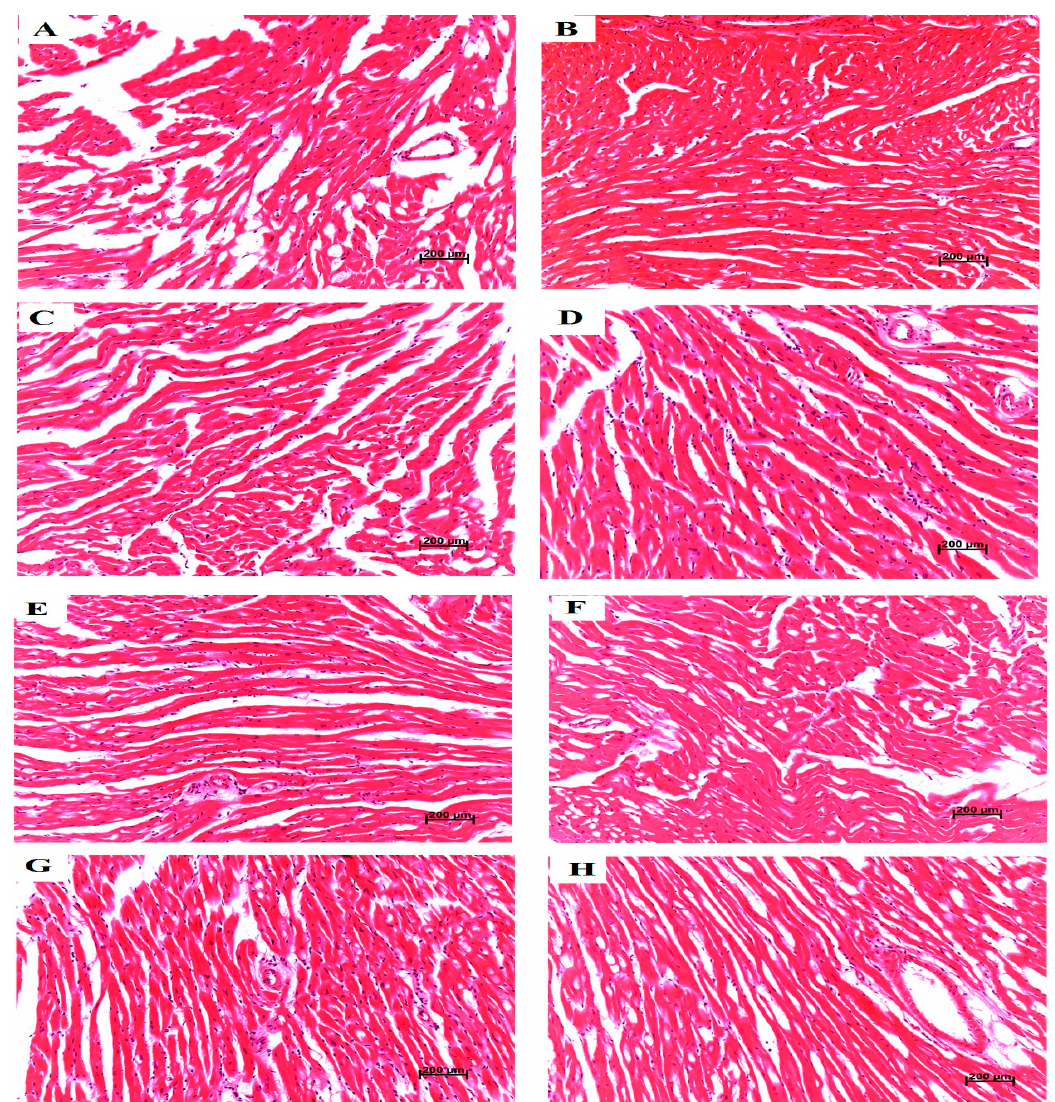
Figure 7. Left ventricle histological evaluation and pathological scores in mice after exposed to PM 2.5 . ( A – D ) represent histological lesions (×200) of left ventricle in C57BL/6 mice exposed to PM 2.5 in dose of 0 (control), 3, 10, and 30 mg/kg b.w., respectively; ( E – H ) represent histological lesions (×200) of left ventricle in ApoE − / − mice exposed to PM 2.5 in dose of 0 (control), 3, 10, and 30 mg/kg b.w., respectively.